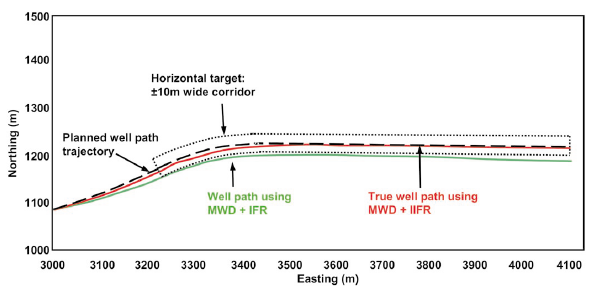
Fig. 7. A horizontal well path drilled towards magnetic east demon- strating the deviation outside a ± 10 m wide corridor from the planned path (dashed line) when MWD with IFR corrections is used (green line). The true well path position (red line) is derived from MWD and MS analysis after correcting for all field sources with IIFR. This wellpath was drilled over 6 days in